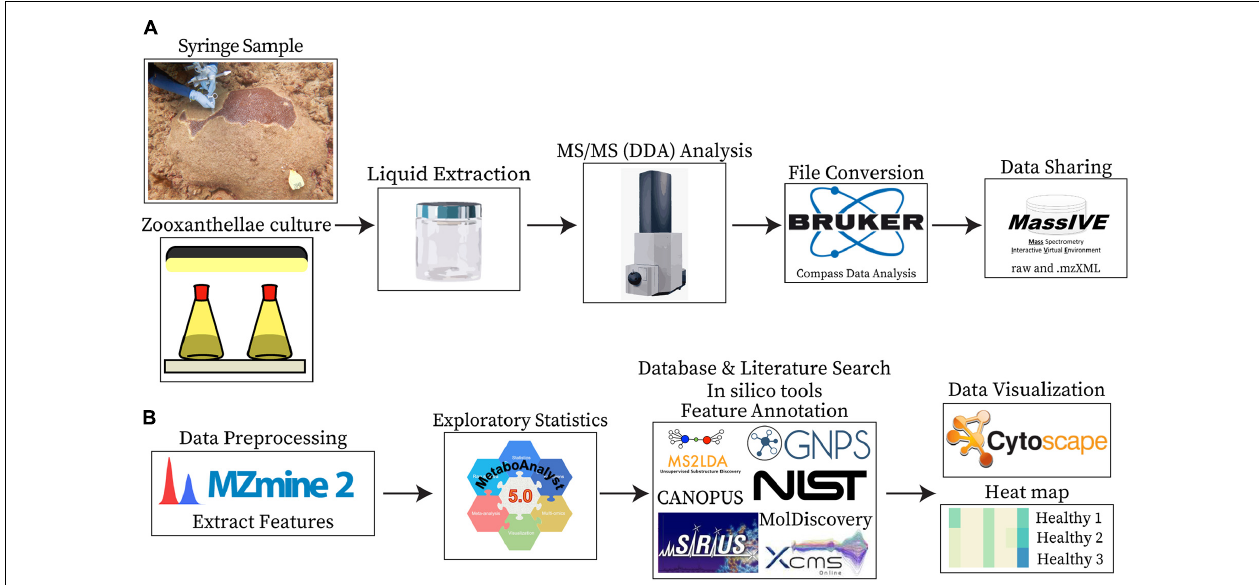
FIGURE 2 | Sample collection, data collection, and analyses. (A) Shows the sample types analyzed (syringe samples collected from coral colonies and cultured Symbiodiniaceae) and the steps employed for data acquisition, conversion, and sharing. (B) Shows the steps employed for data processing, visualization, and the tools utilized for compound